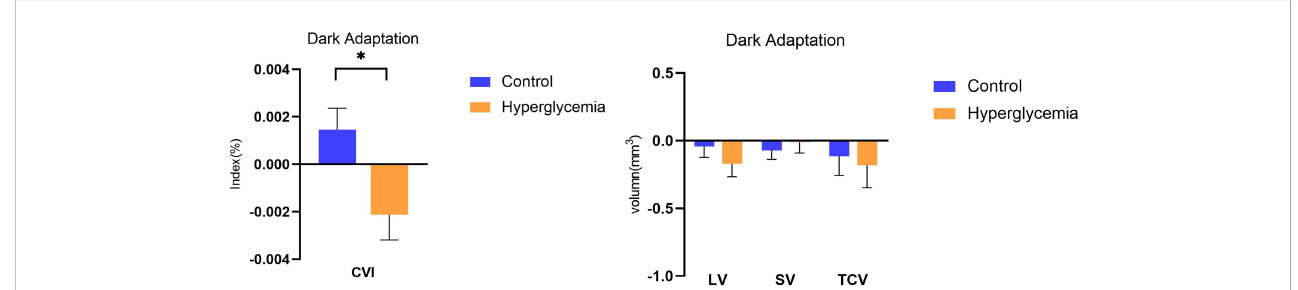
FIGURE 3 Difference in choroidal parameters between the glucose condition and control during dark adaption. Asterisks represent a signi fi cant difference between hyperglycemia and control (P < 0.05). CVI, choroidal vascular index; SV, stromal volume; TCV, total choroidal volume; LV, luminal volume.